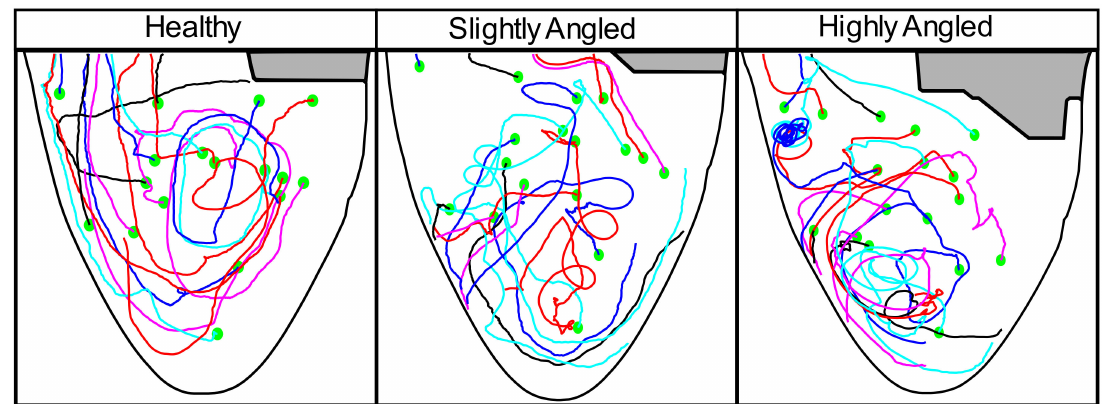
Figure 11. Pathlines over a cardiac cycle for some virtual particles. The green dot represents the initial position. Particles that leave the domain are considered ejected and are no longer